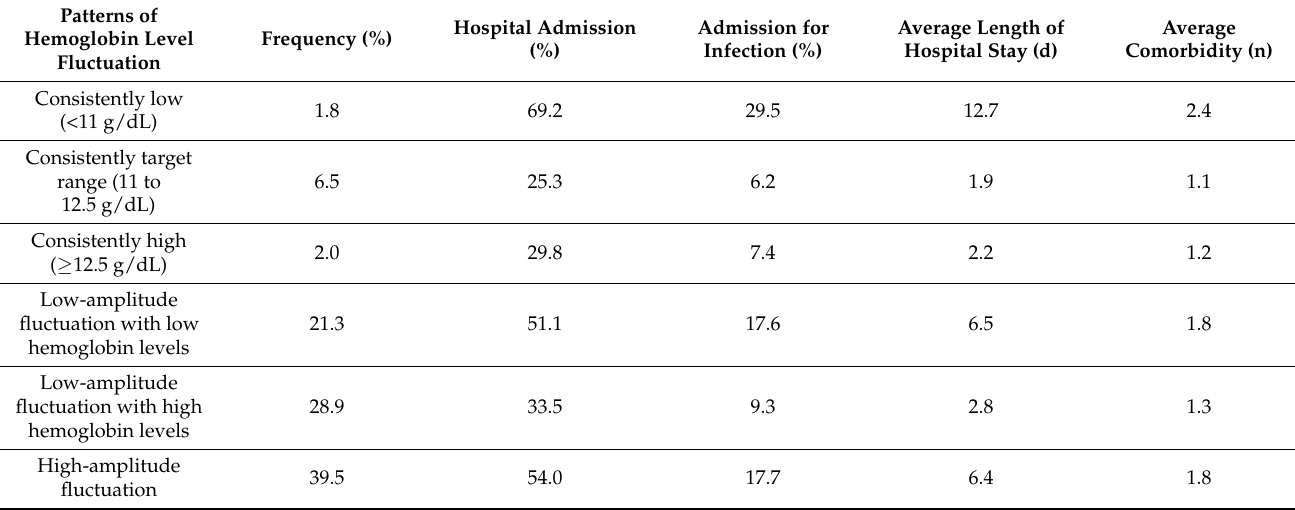
Table 1. Patterns of hemoglobin level fluctuation and association with clinical complications and provider practices. Patterns of Hemoglobin